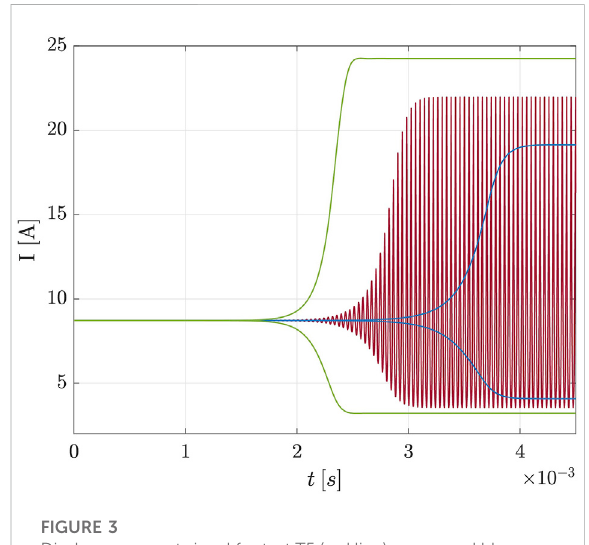
FIGURE 3 Discharge current signal for test T5 (red line); green and blue lines are the envelopes of the discharge current signals obtained by imposing μ ′ (cid:2) 1 . 2 γ n n ′ and μ ′ (cid:2) 0 . 8 γ n n ′ ,